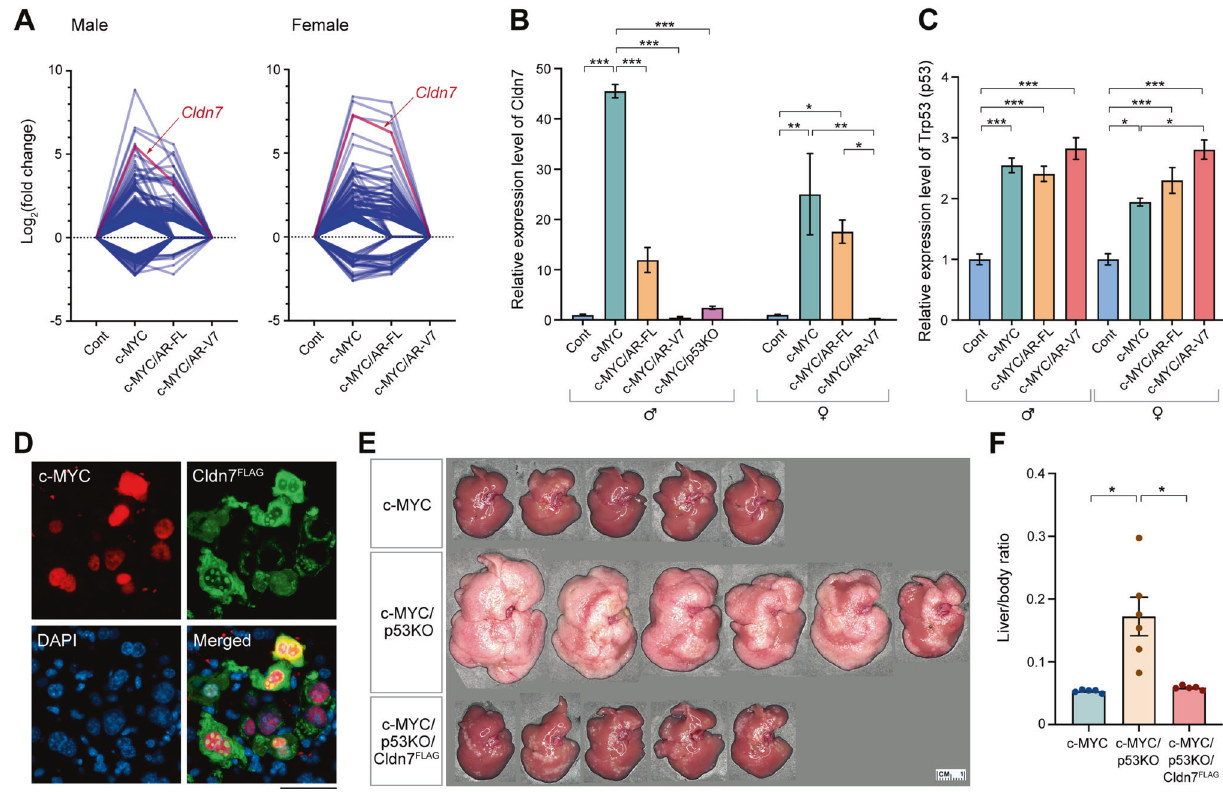
Fig. 4 AR-FL and AR-V7 differently suppressed a tumor suppressor gene Cldn7 that was upregulated by c-MYC overexpression in mouse HCC models. A RNA-seq transcriptome analysis showed that 150 genes that were upregulated by c-MYC were repressed by AR-FL and/or AR- V7 co-expression; and 31 genes that were downregulated by c-MYC were upregulated by AR-FL and/or AR-V7 co-expression in both male (left) and female (right) mice at 20 dpi respectively. Each blue line represents differential expression levels (fold change in reference to control, Y axis) in the tumors of the respective combination of injected gene(s), X axis. Red lines highlight the differential expression levels of Cldn7 in respective samples. B Quantitative RT-PCR for expressions of Cldn7 in respective groups at 20 dpi. Expression of Cldn7 in male mice of c-MYC/ p53KO (hep-c-MYC/p53KO) tumor at 11 dpi (pink bar), indicating that Cldn7 was repressed in p53-de fi cient conditions and hence was likely regulated by p53 [70 – 72]. C Expression of p53 in respective mouse groups in male and female, indicating p53 was upregulated by c-MYC but not signi fi cantly affected by AR-FL or AR-V7 co-expression. D Immuno fl uorescent images of c-MYC (red), Cldn7 FLAG (green), and DNA (blue) in the liver of hep-c-MYC/p53KO/Cldn7 FLAG mouse at 2 dpi, showing co-expression of the respective transgenes in the same cells.